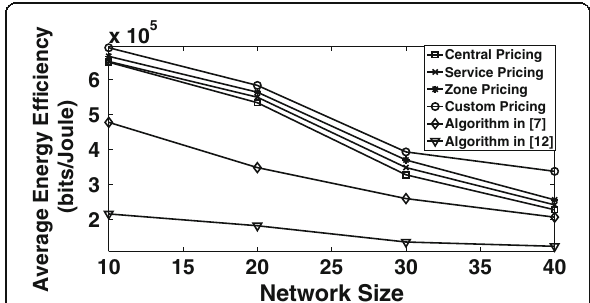
Fig. 2 Users ’ average energy efficiency versus the number of users